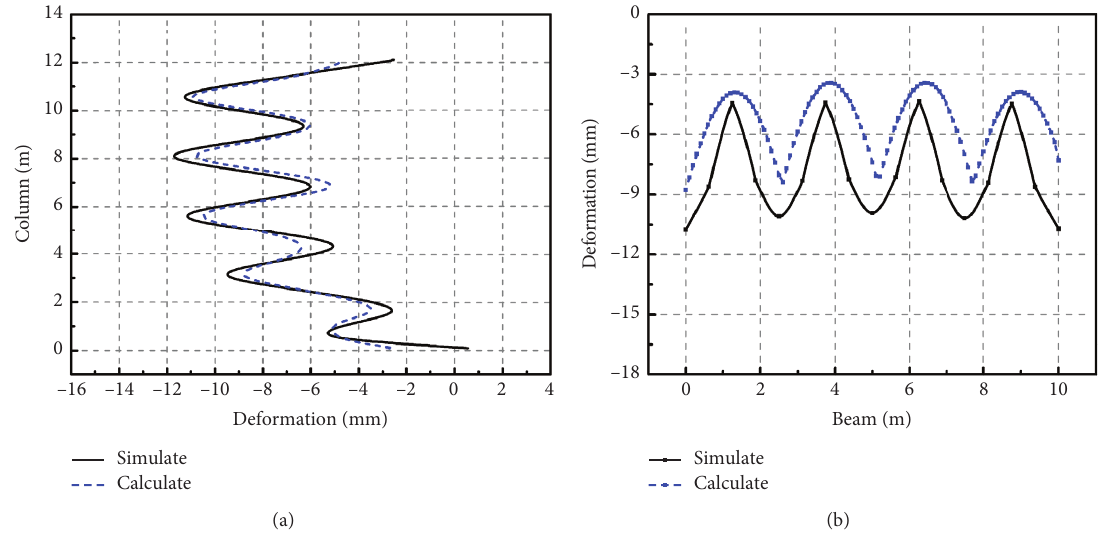
Figure 8: Deformation curve. (a) Column. (b) Beam.